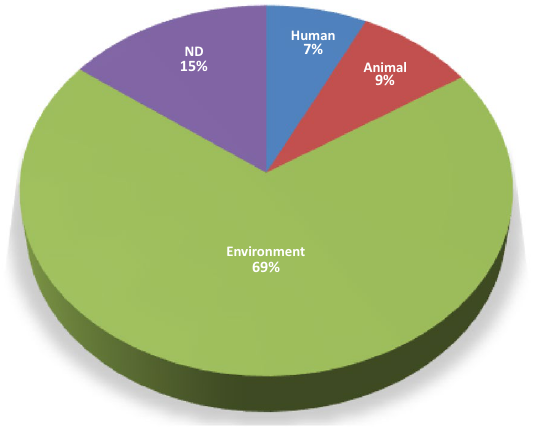
Figure 1. Pie chart of bacterial sources from which sequences were obtained. ND, no